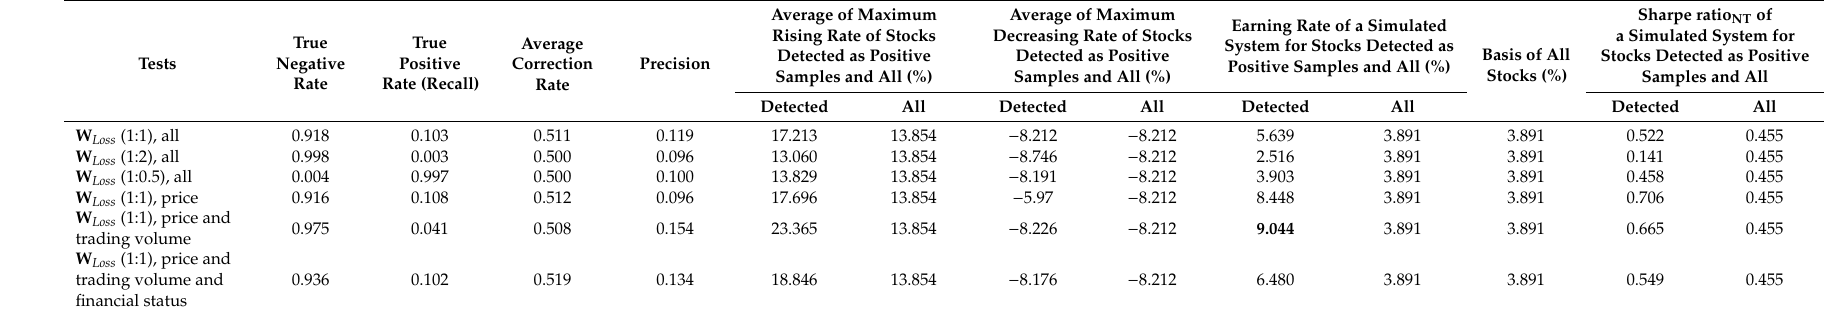
Table 8. Ranking-based stock classification considering historical volatility using di ff erent W Loss values and di ff erent features (all: all features; price: price-related features; trading volume: trading volume feature; financial status: company financial status-related features).